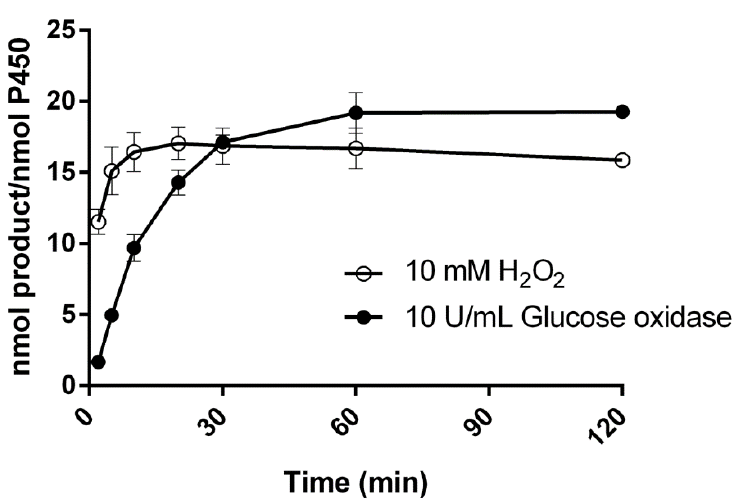
Figure 6. Comparison of external addition of H 2 O 2 generation and in situ H 2 O 2 generation to support the atorvastatin 4-hydroxylation activity of CYP102A1. The reaction mixtures included atorvastatin substrate at a concentration of 200 µ M and 0.20 µ M CYP102A1 in 100 mM of a potassium phosphate buffer (pH 7.4). To start the reaction, 10 mM H 2 O 2 was externally added to the reaction mixtures ( ○ ) or 4 g/L of glucose and 10 U/mL of glucose oxidase were added ( ● ).